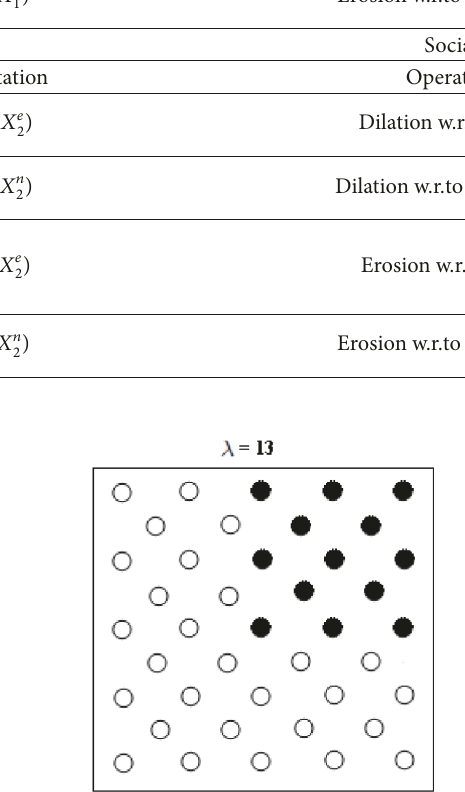
groups and low priority members. The operations